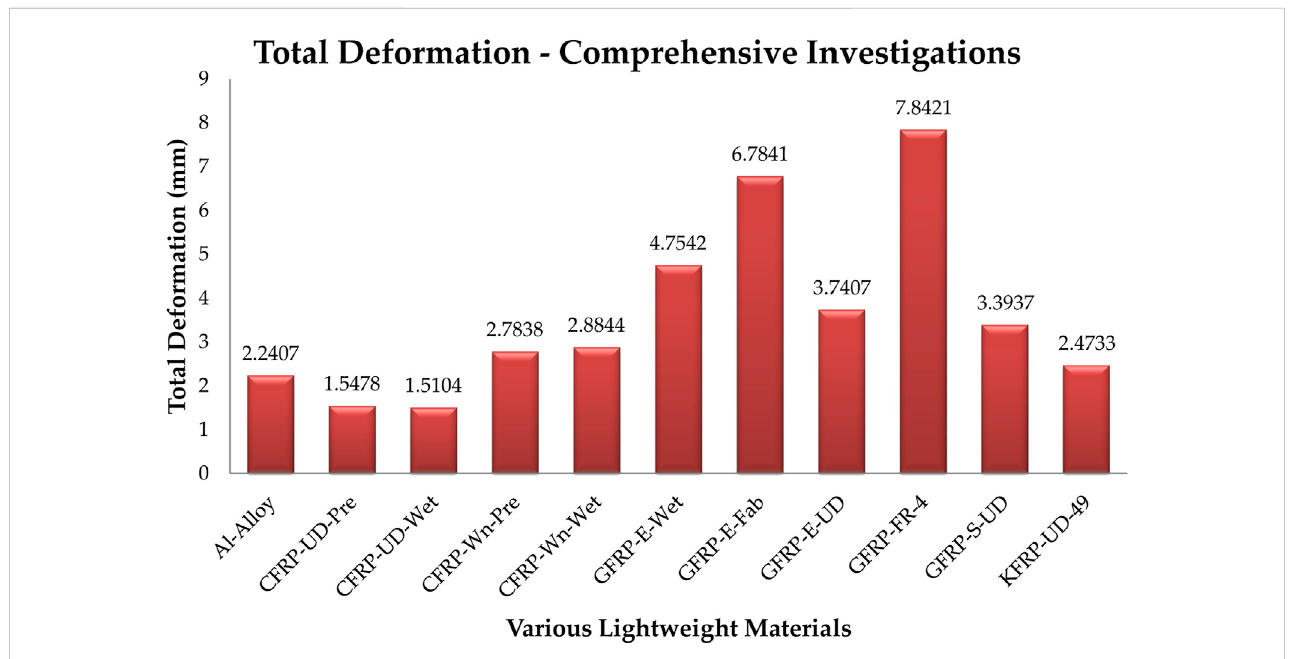
Comprehensive report of total deformation of main rotor of